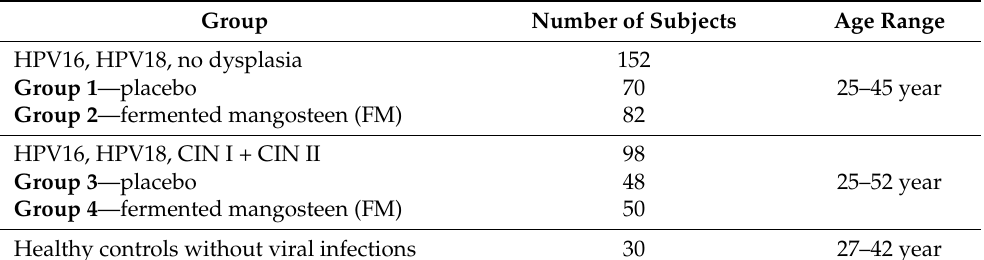
Table 2. Demographic and clinical data of women—participants in placebo-controlled trial on the clinical efficacy, oxidative markers, and TNF-alpha ligand levels of fermented mangosteen (FM)